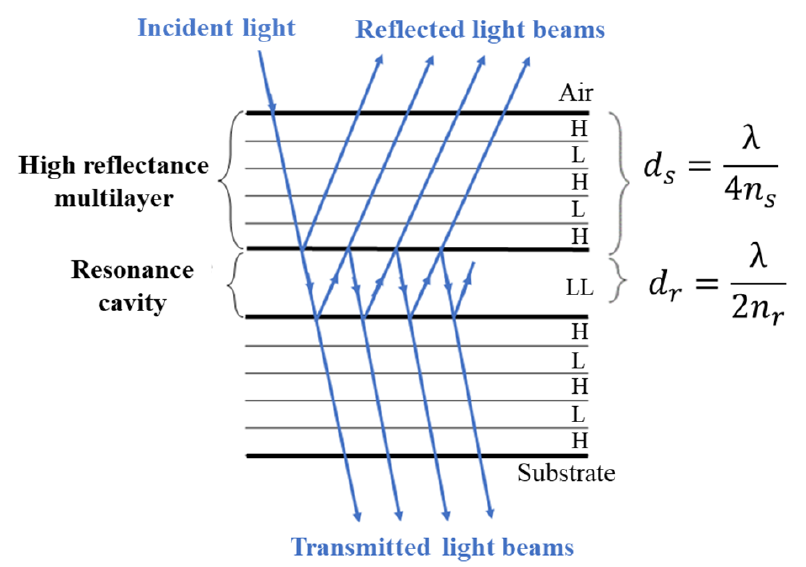
Figure 2. Multilayer thin-film optical filter structure. In the scheme, λ is the transmitted wavelength and n is the refractive index of the resonant cavity material. Considering a first order interference and a light incidence angle of 0°, d r and d s expressions describe the calculus of the resonance cavity and mirror thicknesses, respectively [17].